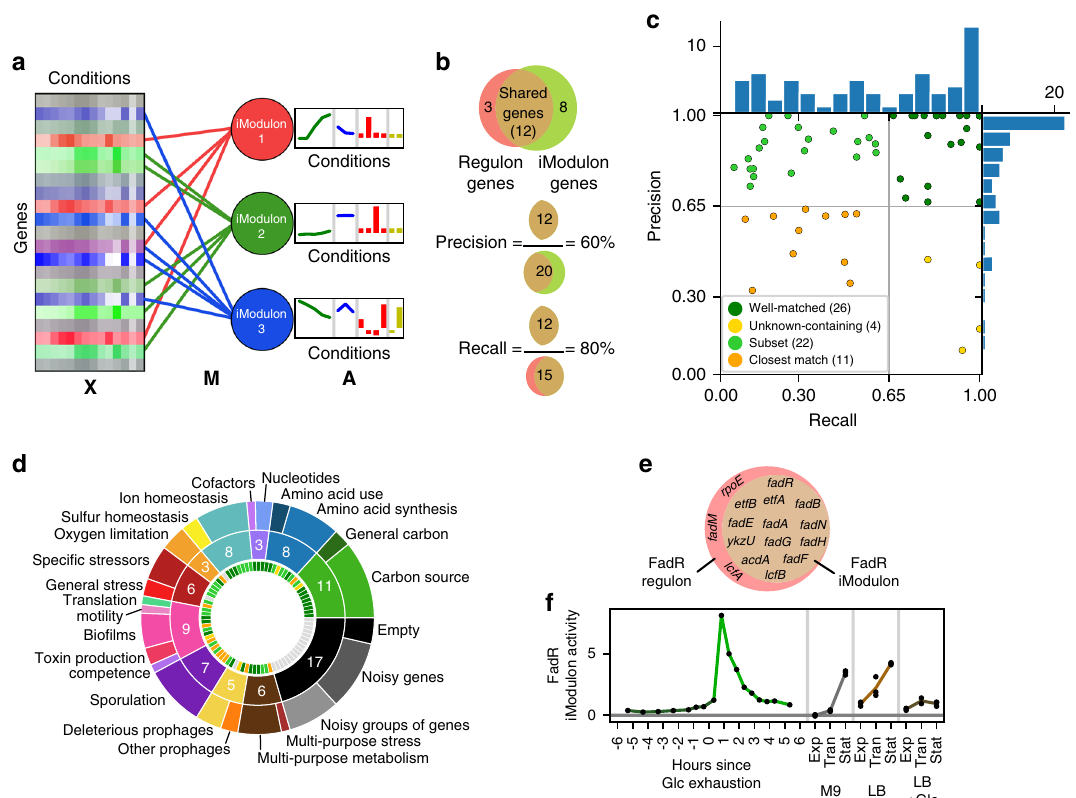
Fig. 1 Independent component analysis (ICA) extracts regulatory signals from a compendium of transcriptomic data. a Given a matrix of gene expression data, X (Supplementary Data 2), ICA identi fi es independently modulated sets of genes (iModulons) in the transcriptome which are linked to genes through the matrix M (Supplementary Data 3). Three iModulons are symbolically represented; the red iModulon consists of four genes, and the green and blue iModulons consist of fi ve genes. The condition-dependent activities of the iModulons are stored in matrix A (Supplementary Data 4). The bar chart indicates the activity levels of the iModulons under different conditions, where the colors indicate different experiments. The three matrices are related as X = M * A . b Graphical representation of the de fi nitions of precision and recall of a given iModulon and the corresponding regulon (example numbers are shown). c Scatter plot of precision and recall of the enrichments for the 63 (out of 83) iModulons that were matched to a regulon. Histograms in the margins demonstrate the high precision of most enrichments (see Supplementary Data 7, Supplementary Fig. 1c for more details). d Donut chart of iModulon functions. The outermost ring lists speci fi c functions and the center ring lists broad functions, with the number of iModulons in the broad category shown in white. The innermost ring shows the regulon con fi dence quadrant of the corresponding iModulon, as de fi ned in c . e , f An example iModulon that was enriched for FadR. e Venn diagram of the FadR iModulon genes and the FadR regulon (non-coding RNAs have been omitted). f Activity level found in a row of A for four experiments (separated by vertical gray lines) from the data set. Activity levels increase during growth in the absence of glucose (M9 media, gray; LB media, light brown), remain low during growth in the presence of glucose (dark green, dark brown), and spike upon glucose (Glc) starvation (green). “ Exp ” , “ Tran ” and “ Stat ” refer to exponential, transition, and stationary phase, respectively. See Supplementary Data 1 for